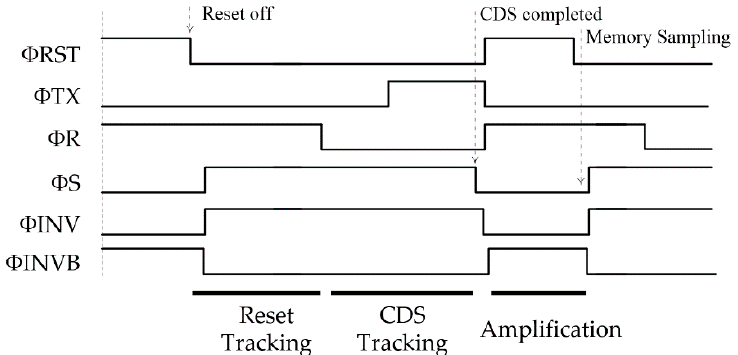
Figure 5. Pixel operation timing for both Type A and Type B (pipeline version).